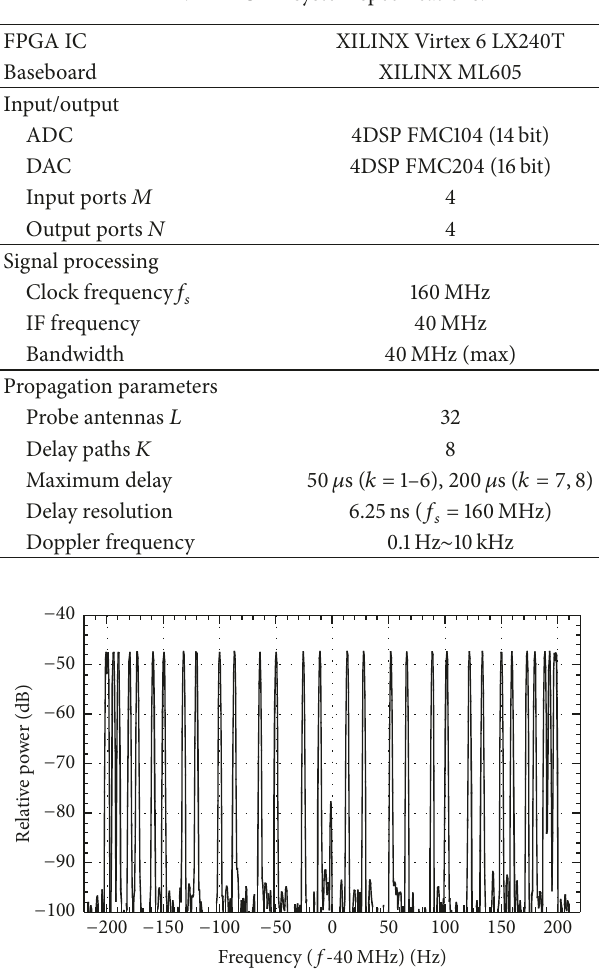
Table 2: MIMO FE system specifications.